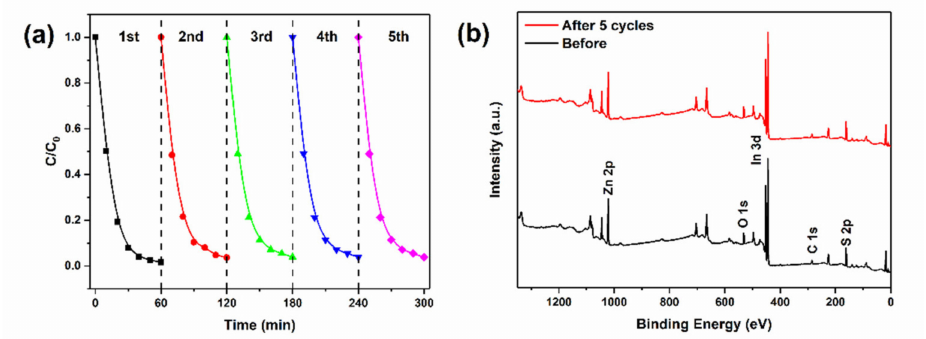
Figure 8. ( a ) Cycling tests for the photodegradation of NPX by rGO / ZIS-1. Reaction conditions: [NPX] = 10 mg · L − 1 , [photocatalyst] = 0.2 g · L − 1 , natural pH, λ > 420 nm. ( b ) Survey XPS spectra of rGO / ZIS-1 before and after the five cycle